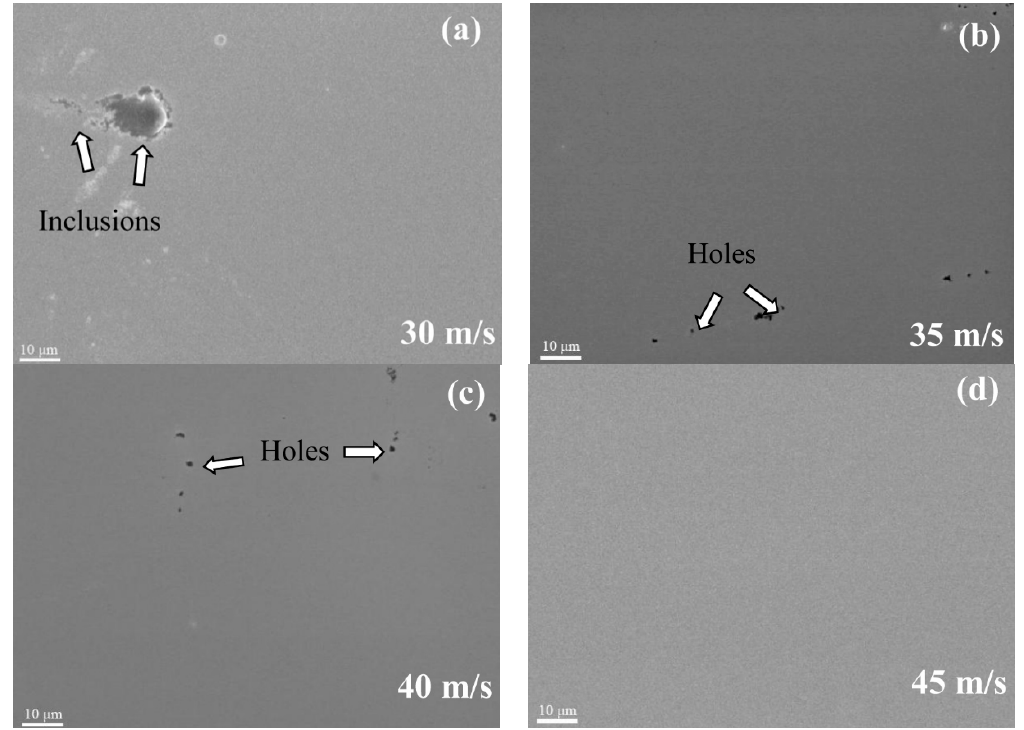
Figure 4. SEM images of the amorphous (TiZr) 0.5 (Ni 0.6 Cr 0.1 V 0.1 ) 2.1 ribbons’ surfaces with different spinning speeds. The spinning speed were ( a ) 30 m/s, ( b ) 35 m/s, ( c ) 40 m/s and ( d ) 45 m/s,